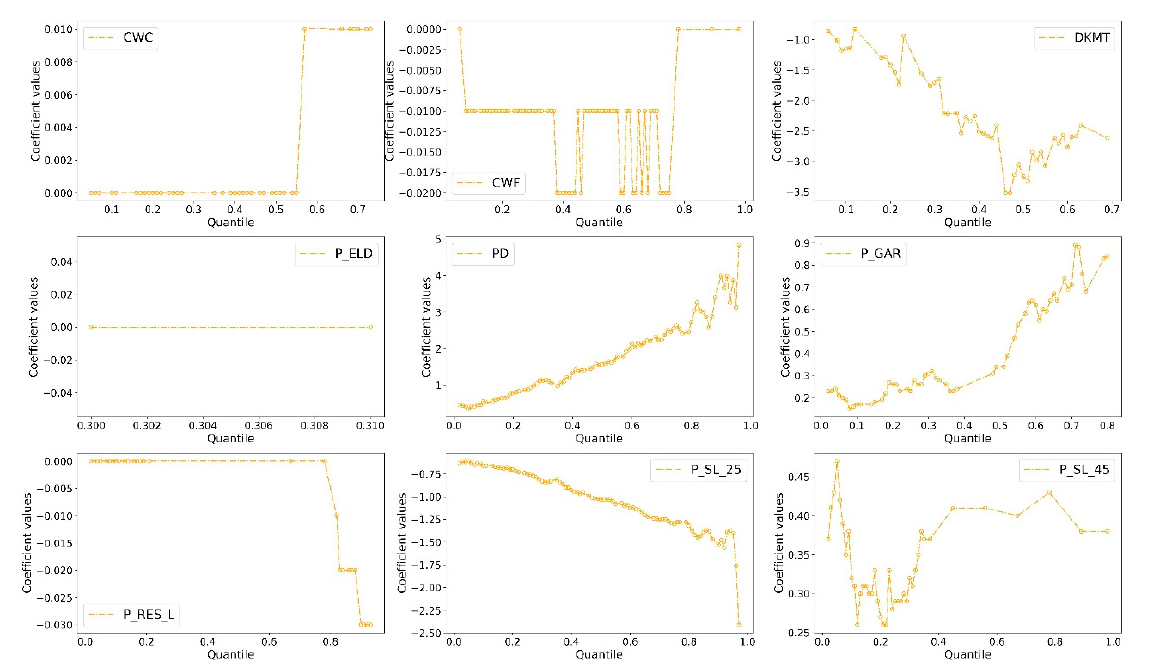
Figure 4. Coefficient estimates in SARQ model with total crash rate as the dependent variable.